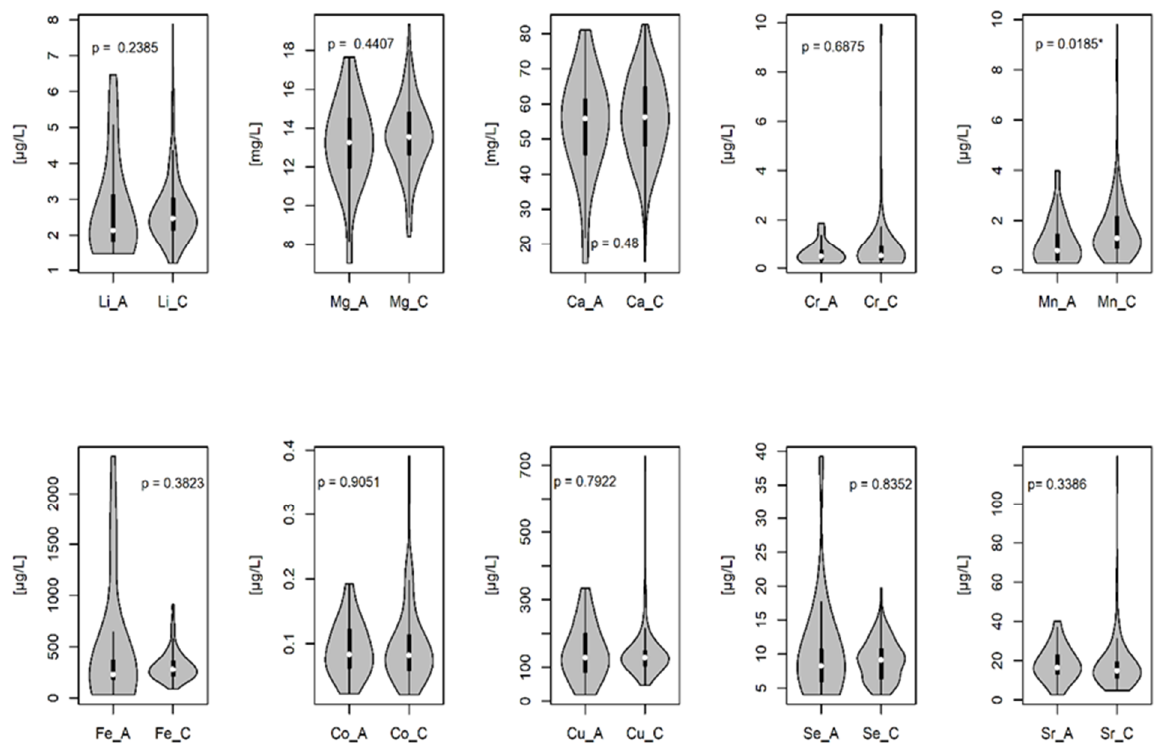
Figure 1. The concentration of essential elements in the amniotic fluid. C-group with normal fetal karyotype; A-group with fetal chromosomal abnormalities. The lower part of the violin chart is the minimum mineral concentration; the upper part of the violin chart is the maximum mineral concentration. The lower range of the black box is the lower quartile Q1; the upper range of the black box is the upper quartile Q3. The white dot in the black box is the median value; p -significance level. * statistically significant differences at the level of α = 0.05.